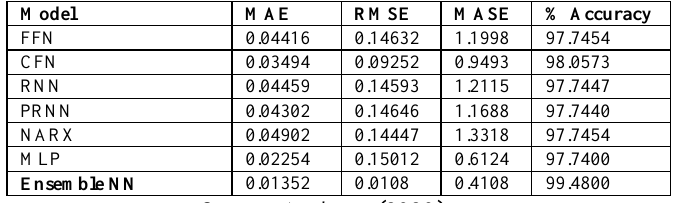
Table 1: Performance evaluation of models based on MAE, RMSE, MASE and Percentage Accuracy.